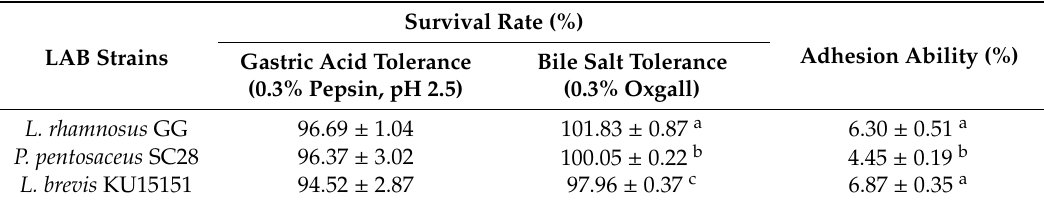
Table 1. Artificial gastric juice and bile salt tolerance (%) and adhesion ability (%) of lactic acid bacteria (LAB)